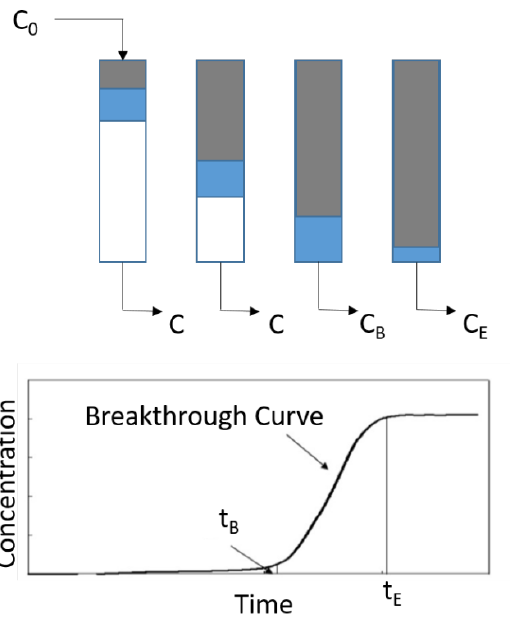
Figure 5. A schematic representation of the movement of the adsorption zone and the related breakthrough curve (adapted from: Muftah H. El-Naas [16]).